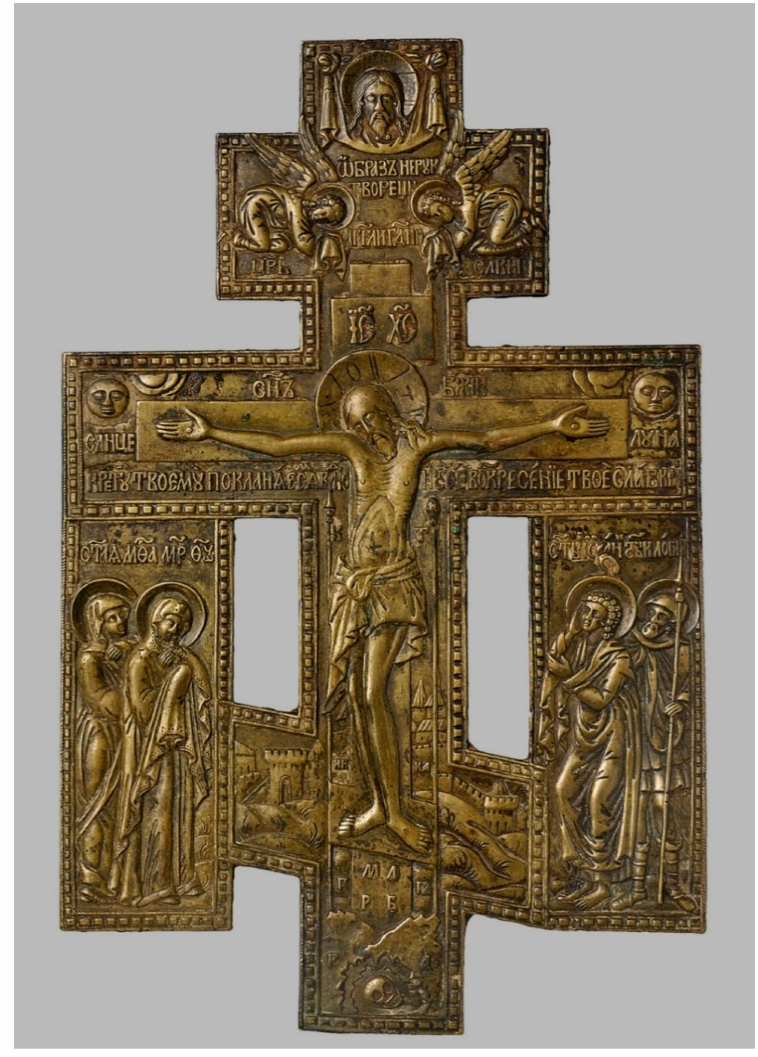
Figure 3. Crucifixion of Christ, Northern Russia, workshop of priestless Old Believers, beginning of 19th c., brass, 23.2 × 15.1 cm, National Museum in Warsaw, photo: Zbigniew